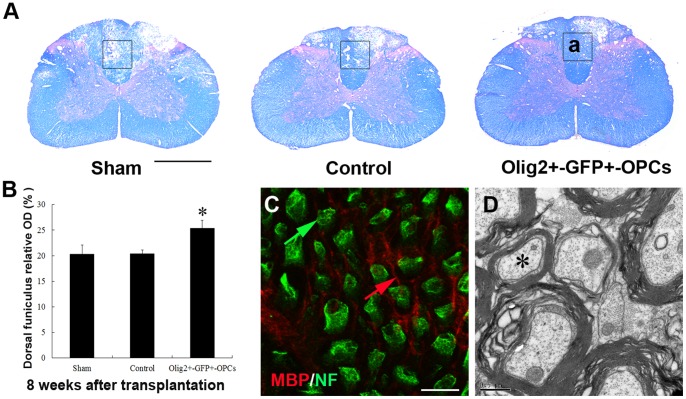
Transplantation of Olig2+-GFP+-OPCs results in a delayed demyelination and cavitation.(A) LFB/H&E staining showed smaller cystic cavitations in the transplanted cord than those in the sham and the control group in the dorsal funiculus. (B) Optical densities of dorsal funiculus in spinal cord was significantly increased in rats grafted with Olig2+-GFP+-OPCs, as compared to the sham and the control group (*p < 0.05, n = 12). (C) Enlargement of framed area in part a, illustrated immunostaining of MBP and NF, showing axons (green arrow) with or without myelin (red arrow). (D) Electron microscopy confirmed the structure of axons (asterisk). Bar, 200 µm (A); bar, 35 µm (C); bar, 0.5 µm (D).